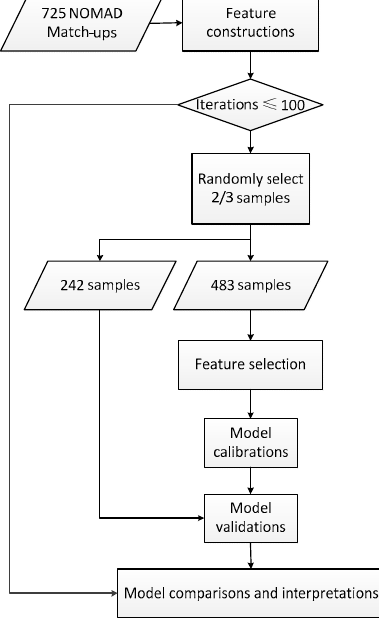
Figure 1. Framework for model development.